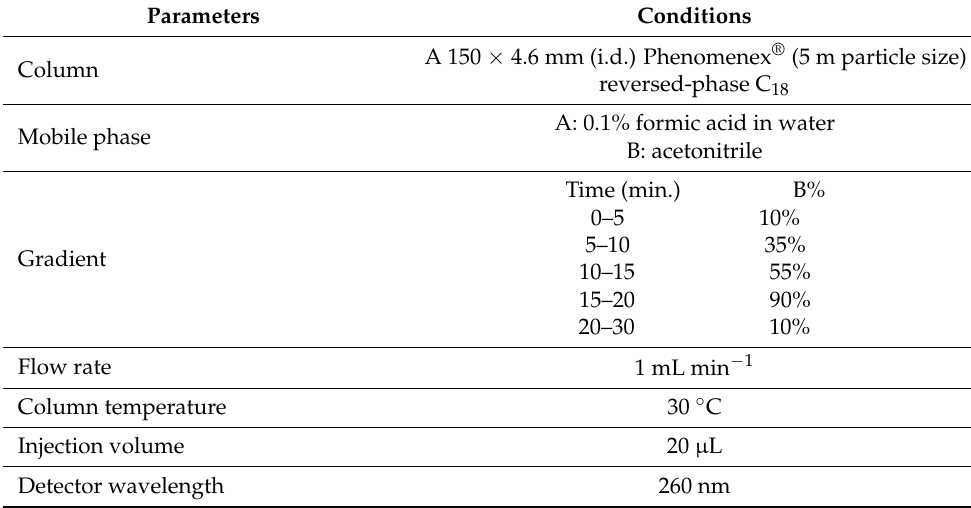
Table 1. The chromatographic conditions for the HPLC-UV